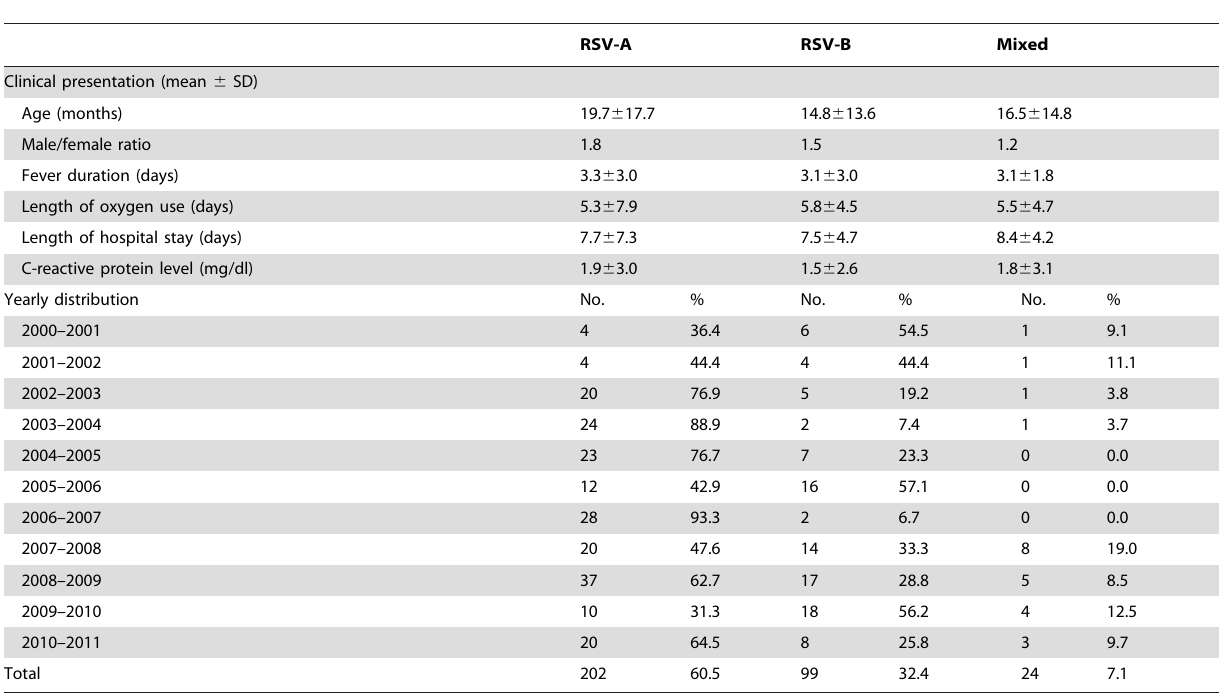
Table 1. Clinical presentations of infected patients and yearly